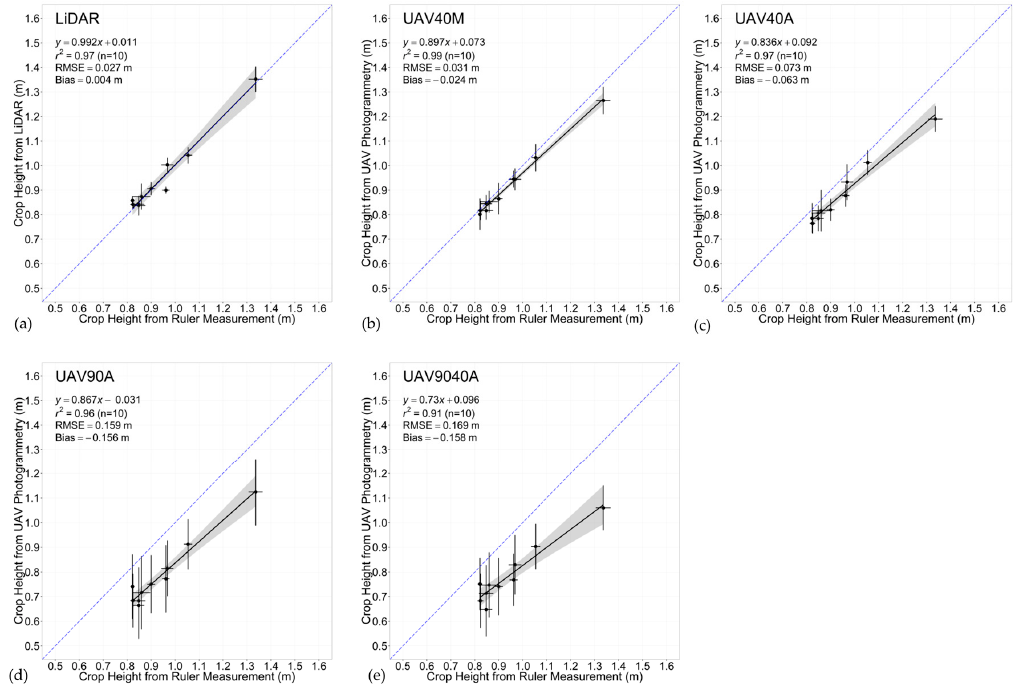
Figure 8. Comparison of crop heights derived from ( a ) LiDAR and ( b – e ) the various UAV-based approaches detailed in Table 4 to those from the ground-based (rule) method for each of the ten plots measured during the 2014 Pilot study. Blue dashed line indicates 1:1 slope.